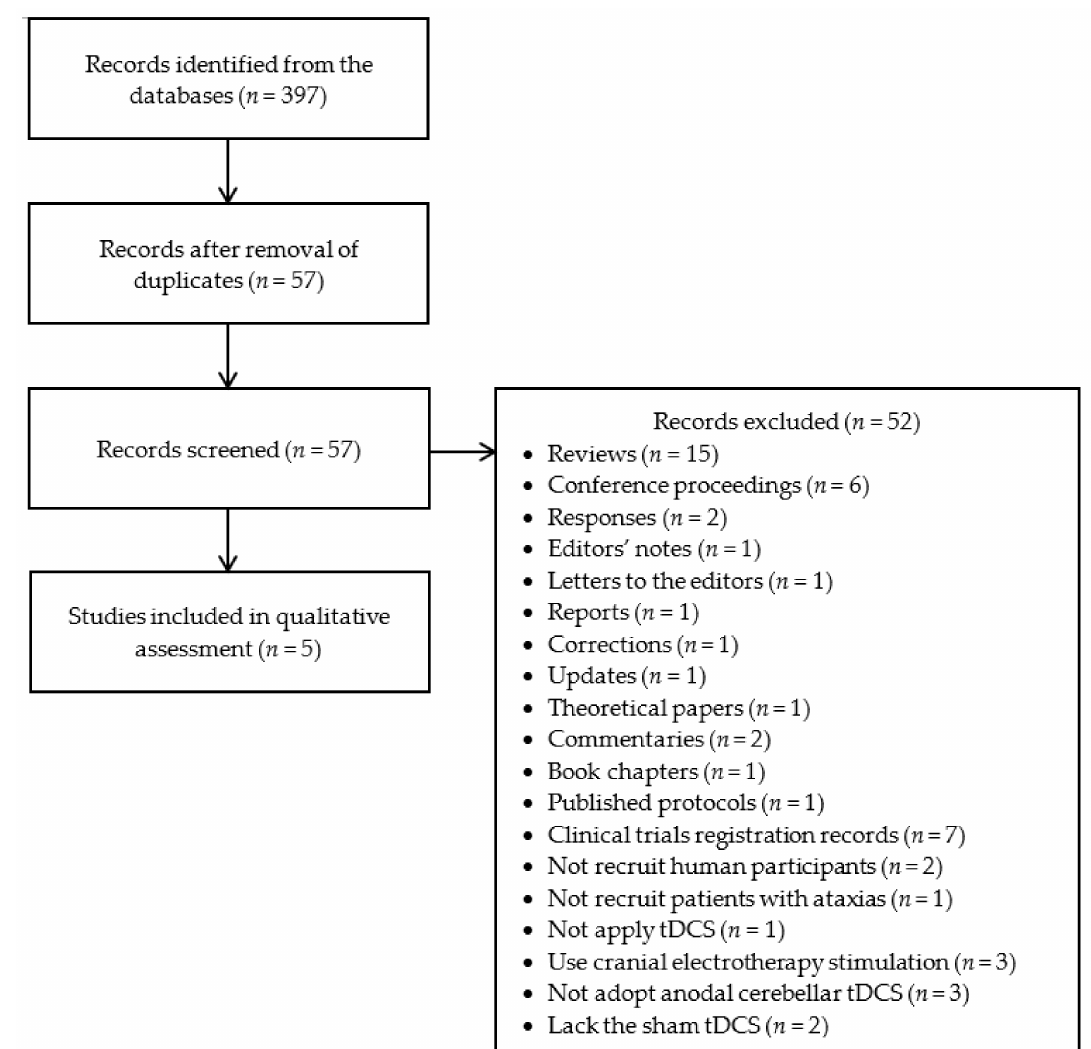
Figure 1. The flow diagram of study selection. tDCS = transcranial direct current